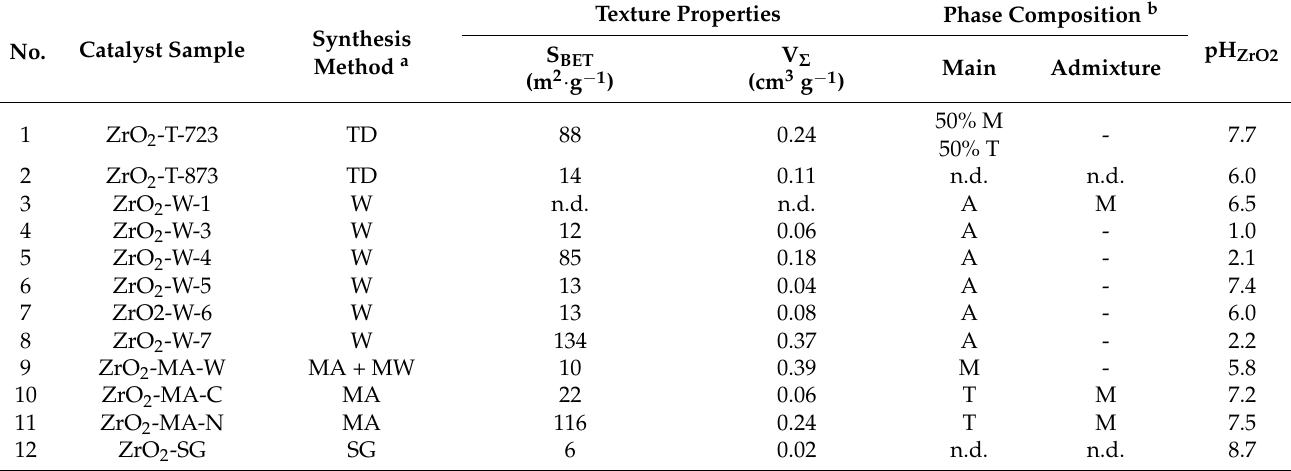
Table 3. Textural properties, phase composition of ZrO 2